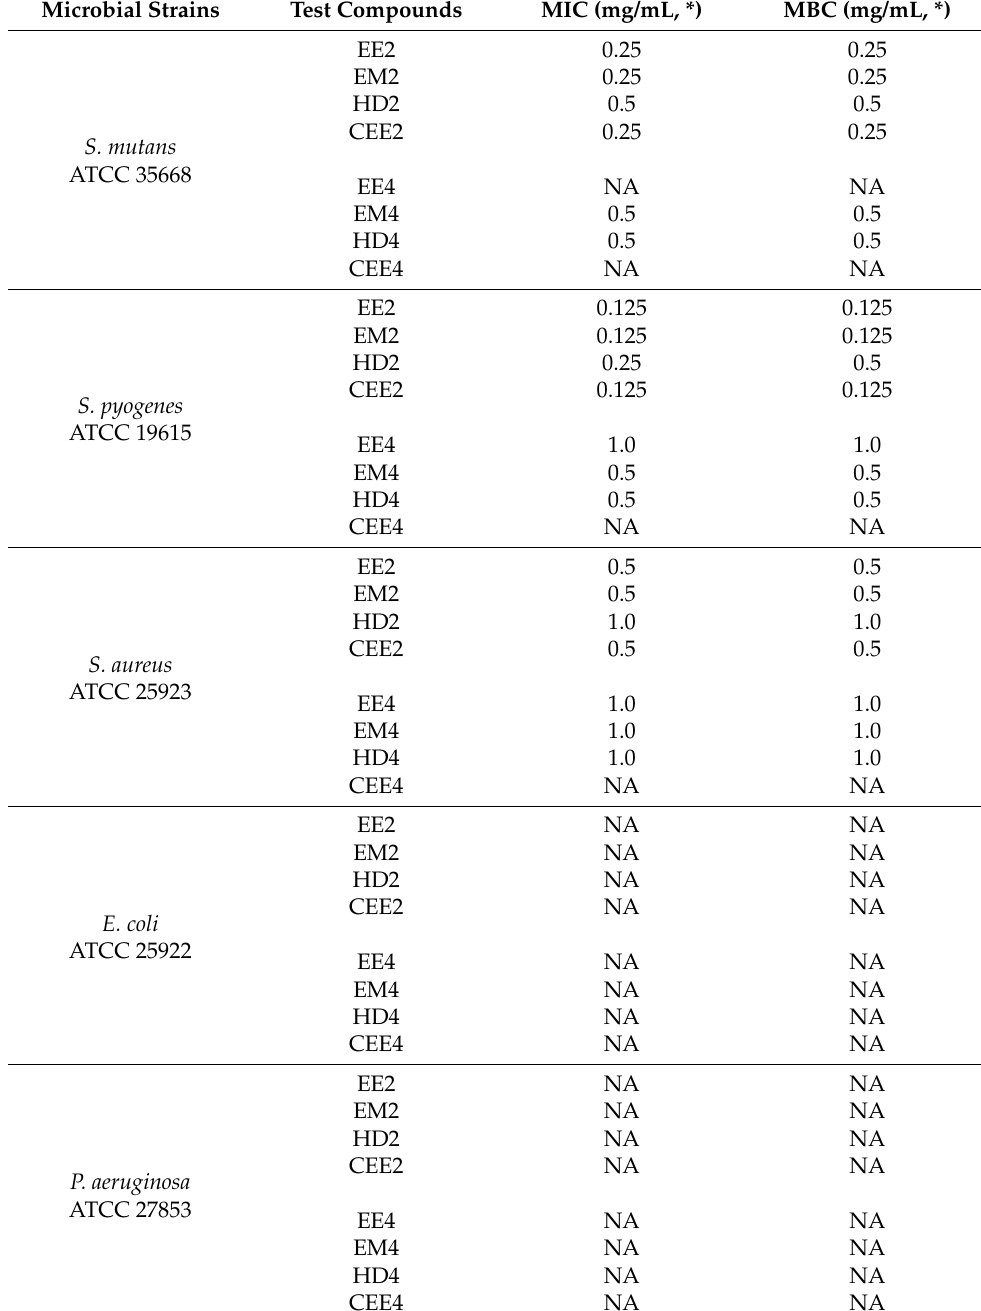
Table 3. Antibacterial activity of test compounds. Microbial